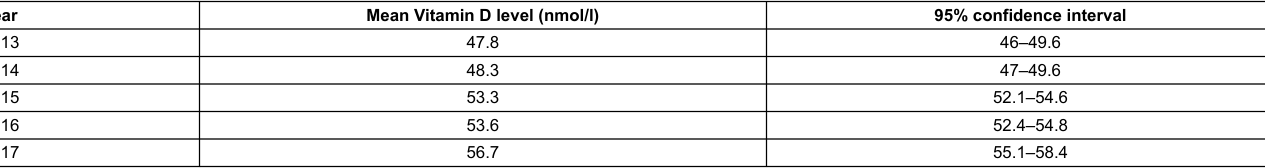
Table 4: Vitamin D concentrations according to year.